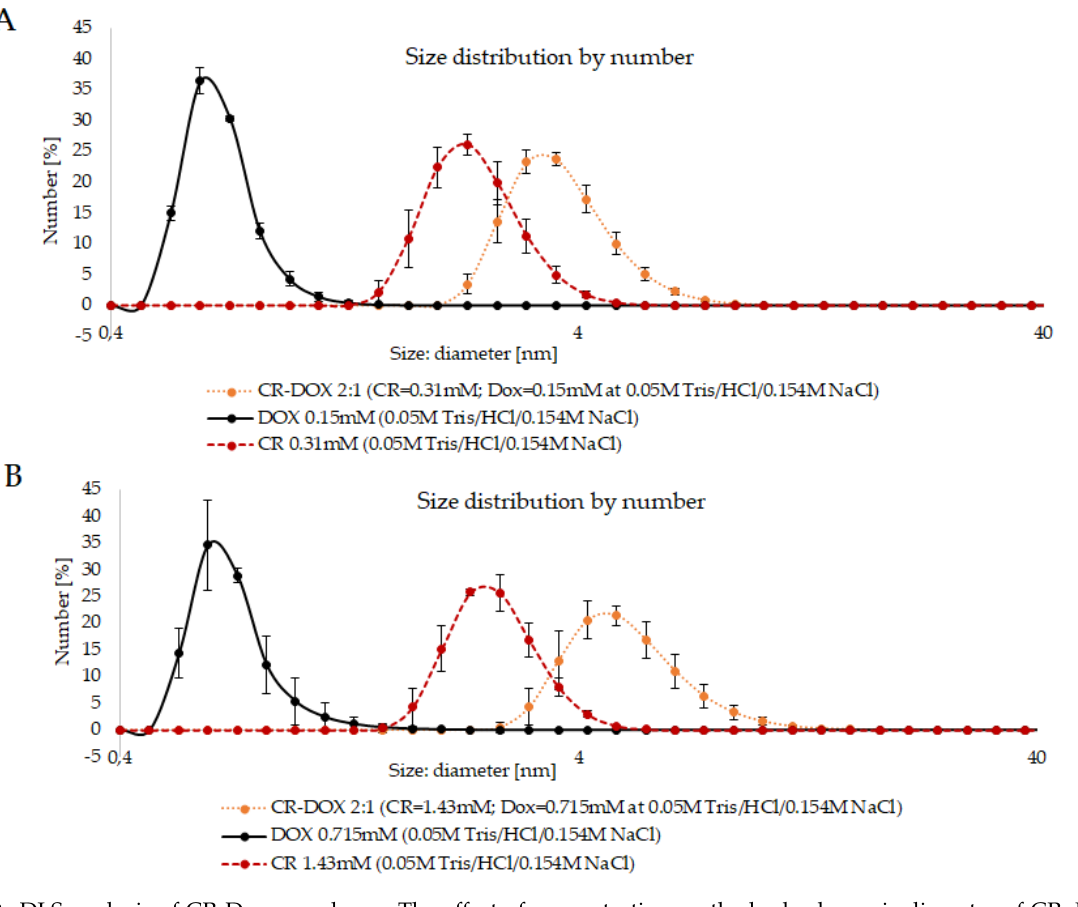
Figure 2. DLS analysis of CR-Dox complexes. The effect of concentration on the hydrodynamic diameter of CR, Dox, and CR-Dox complex. ( A ). lower concentration probes (final concentration of CR: 0.31 mM, Dox: 0.15 mM); ( B ). higher concentration probes (final concentration of CR: 1.43 mM, Dox: 0.715 mM).